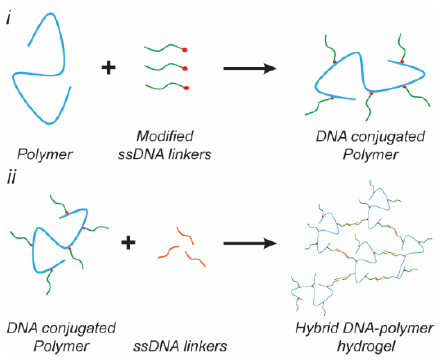
Figure 3. Hybrid DNA–polymer hydrogel formation. ( i ) Polymer chain conjugation with modified ssDNA linkers to form ssDNA conjugated polymer. ( ii ) ssDNA conjugated polymers crosslinked by complementary ssDNA linkers to form hybrid DNA–polymer hydrogel.